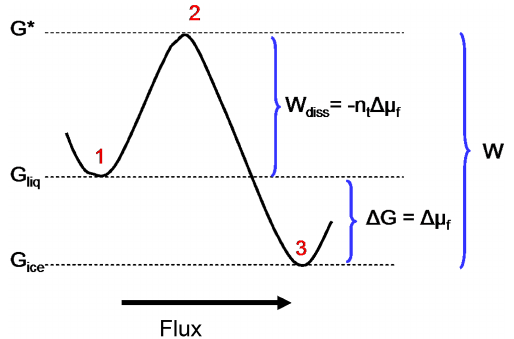
Figure 1. Simplified energy landscape of water molecules in the ice–liquid interface during interface transfer. States 1 and 3 corre- spond to metastable equilibrium positions in the liquid and ice, re- spectively, and 2 corresponds to the transient state. G ice , G liq and G ∗ correspond to the Gibbs free energy of ice, liquid and the tran- sient state, respectively. W and W diss are the total non-equilibrium work and the dissipated work, respectively. (cid:49)µ f is the excess free energy of water and n t is defined in Sect. 2. The bold arrow rep- resents the direction of the net flux of water molecules during the growth of the ice